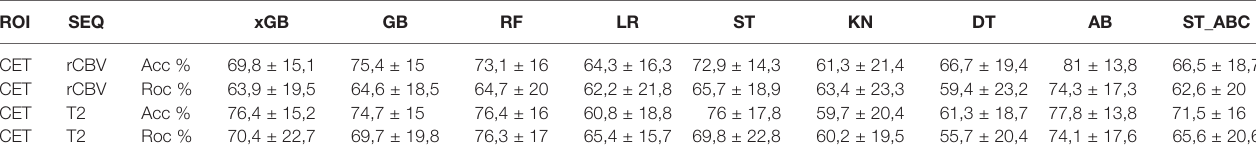
TABLE 6 | EGFR best results (reported as mean ± standard deviation).